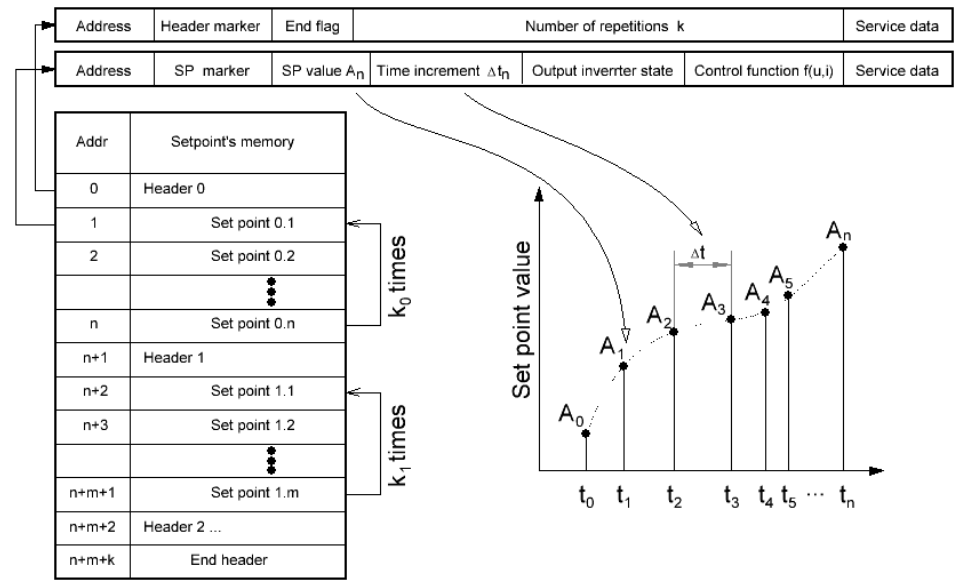
Figure 4. Illustration of the list and structure of set points and their corresponding waveform.